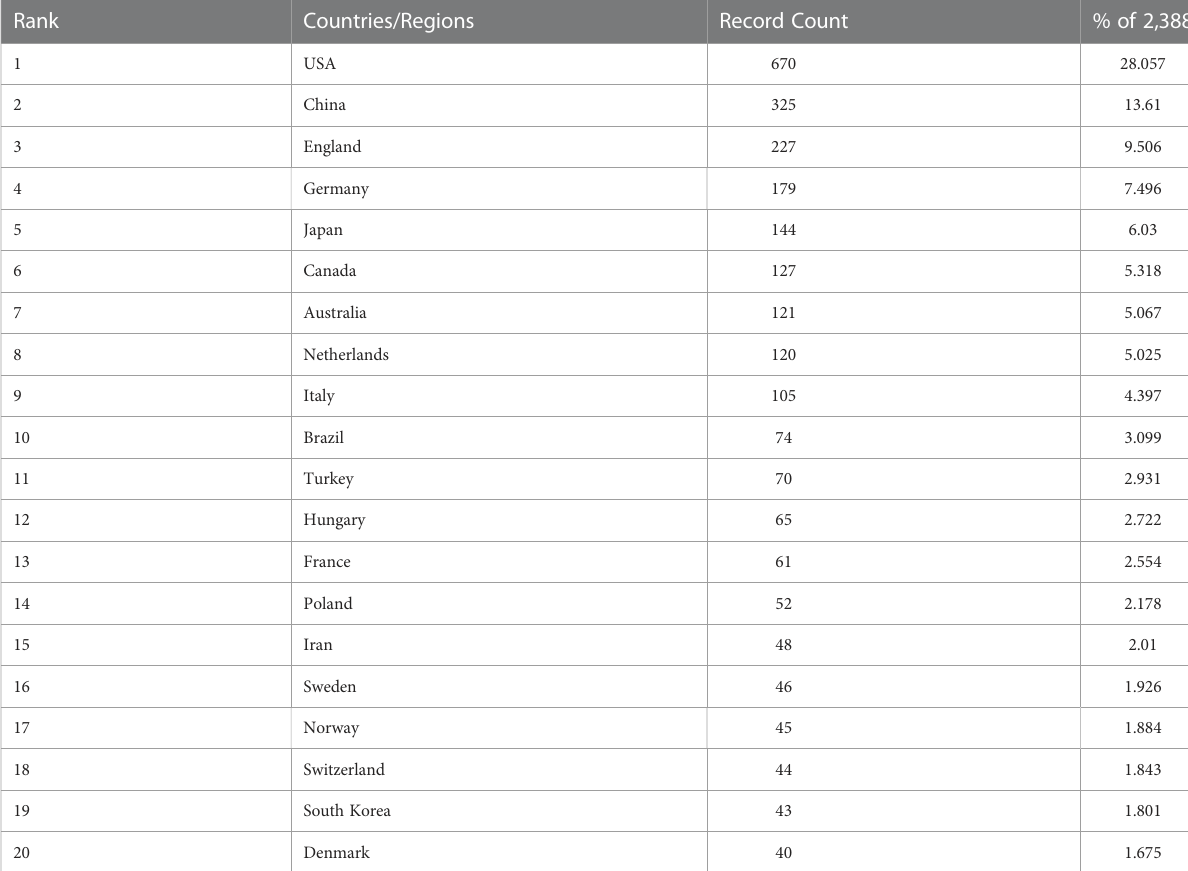
TABLE 1 The top 20 most productive journals published in HDP and immune cells